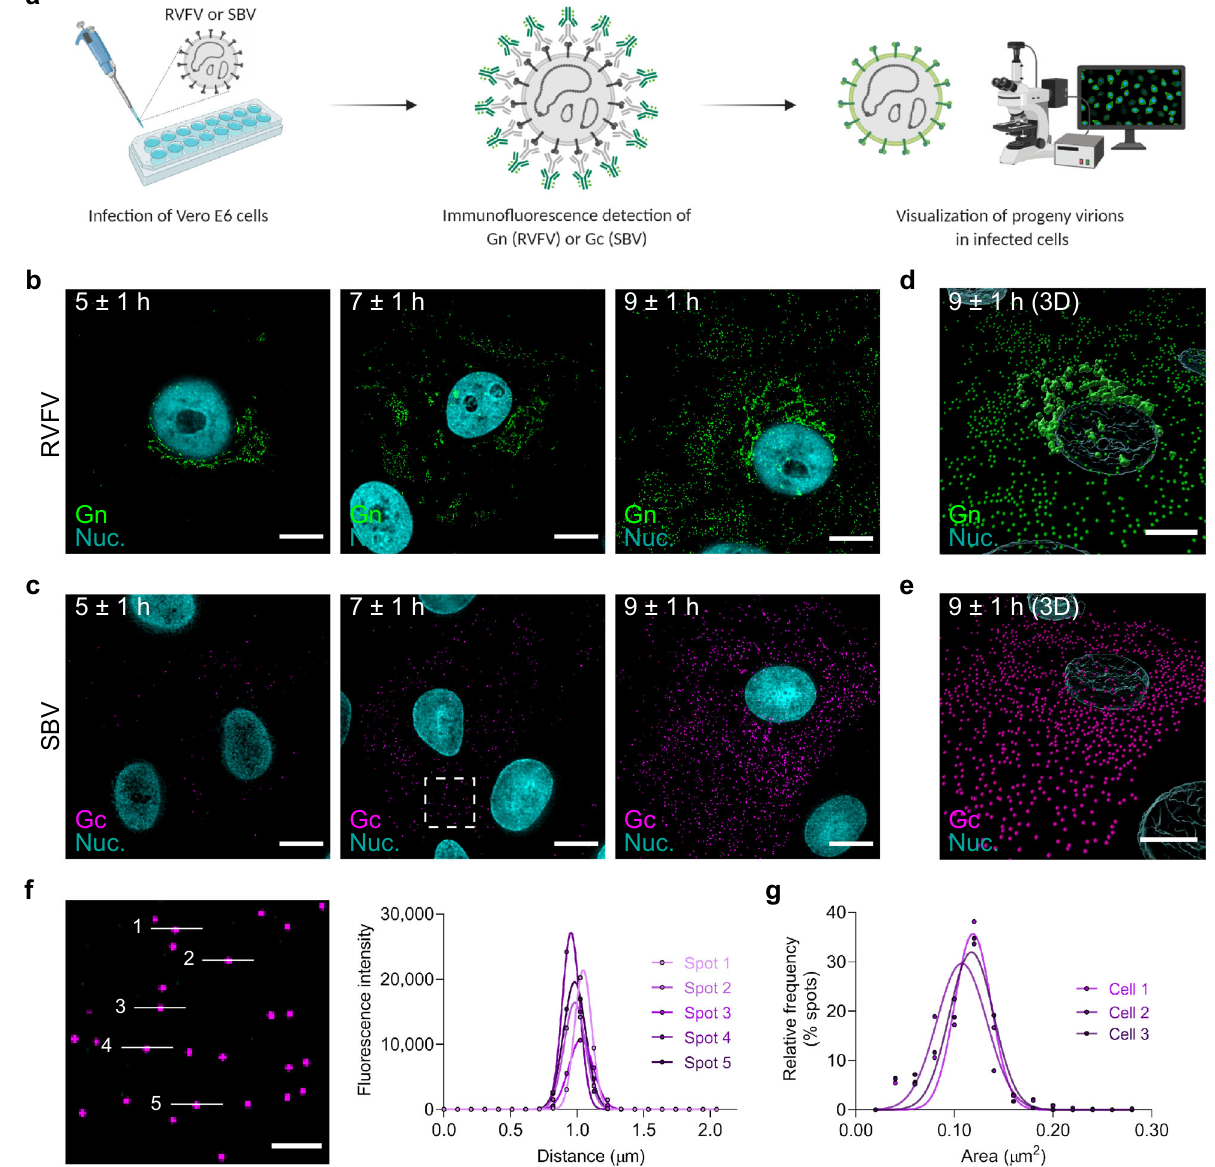
Fig. 2 Immuno fl uorescence detection of newly formed bunyavirus progeny virions at single-particle resolution. a Schematic representation of the experimental setup. Vero E6 cells were infected with RVFV (MOI 1) or SBV (MOI 0.33) and cells were fi xed at de fi ned time points. Progeny virions were detected by immuno fl uorescence. Release kinetics of RVFV particles (green) ( b ) and SBV particles (magenta) ( c ). RVFV virions were detected with antibody 4-D4 48 targeting the Gn glycoprotein in combination with Alexa Fluor 488-conjugated secondary antibodies. SBV virions were detected with serum from an immunized rabbit 52 targeting the Gc glycoprotein in combination with FITC-conjugated secondary antibodies. Cell nuclei (cyan) were visualized with DAPI. RVFV Gn accumulates in a perinuclear region, the site of virion assembly. d , e Three-dimensional representations showing the spatial distribution of virions at the 9 ± 1 h time point created with Imaris using the Surfaces and Spots modes. f Magni fi cation of a region of interest (indicated as a dashed box in the second panel of c ) and fl uorescence intensity plot of the indicated spots. Dots represent data points and lines show Gaussian curves fi tting the data. The unimodal distribution of fl uorescence intensities along the lines crossing the spots is characteristic of single particles. g Histogram of the area of the spots detected in images of SBV-infected cells ( n = 3 cells; more than 500 spots per image). Dots represent data points and lines show Gaussian curves fi tting the data. The unimodal distribution denotes reproducible measurements of single spots within and between images. Images are merged maximum intensity projections of two channels. Scale bars, 10 µ m ( b – e ), 2 µ m ( f